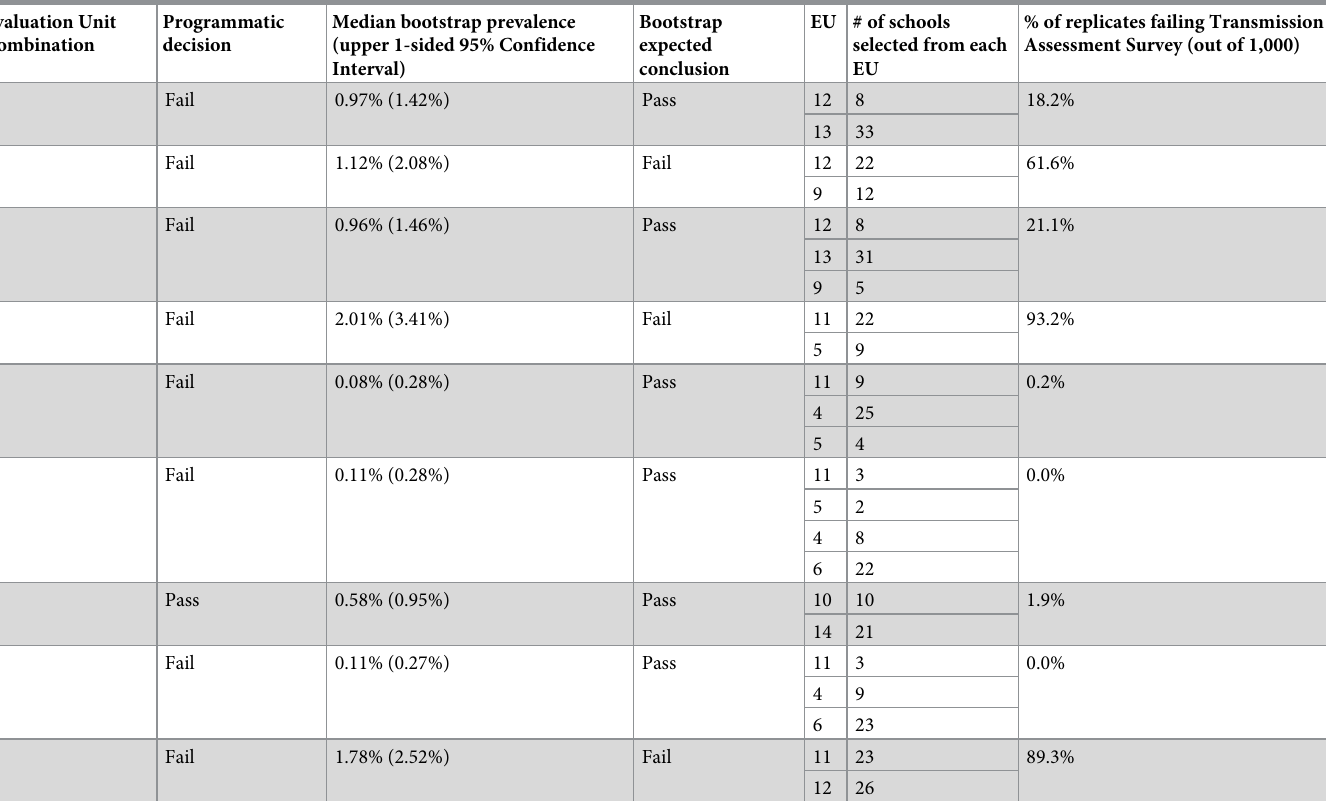
Table 3. Results of bootstrapping results simulating Transmission Assessment Surveys in combination Evaluation Units. Evaluation Unit